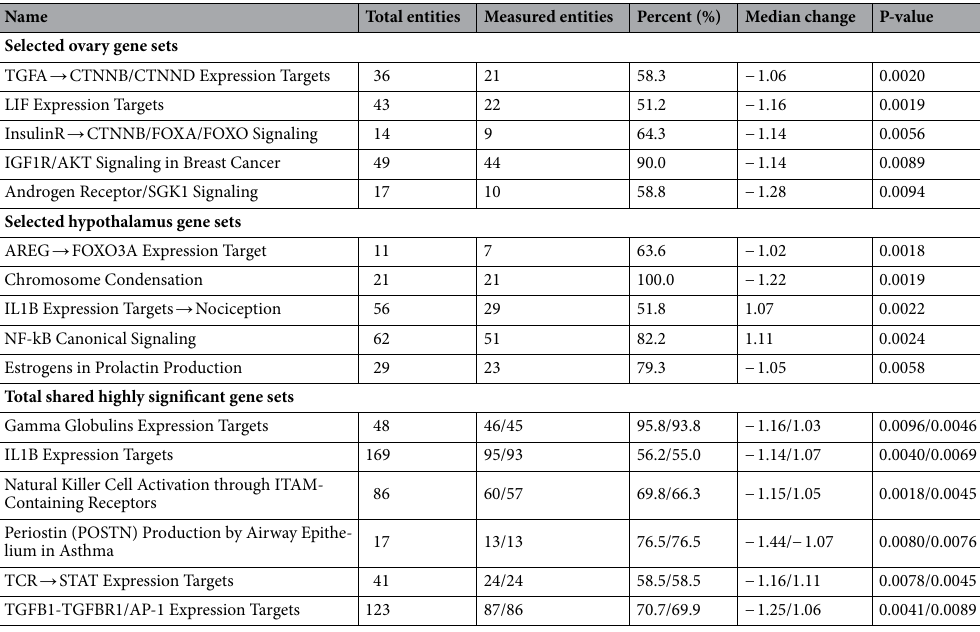
Table 1. Selected highly significant gene sets (P < 0.01 with > 50% measured entities in a pathway) following PNX-14 treatment. Five selected gene sets unique to ovary and hypothalamus are provided, followed by six total sets shared between organs. See Supplementary Data for full lists. Total entities, measured entities, and percent (%) refer to the total number of genes in the set, number of those genes detected with significant fold expression changes, and the percentage, respectively. Median change refers to the median positive or negative log2 fold change across all measured entities in that gene set. For shared gene sets, ovary and hypothalamus values are provided before and after slashes, respectively.